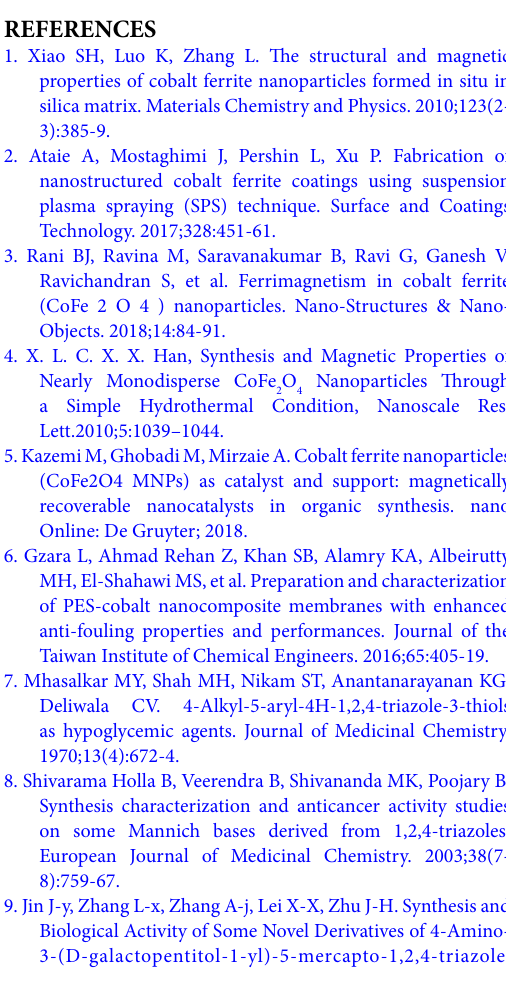
No. of Fig. 11. Reusability studies of CoFe2O4@SiO2 for the synthesis of 5-(4-Chlorophenyl-1,2,4-triazolidine-3-thione (2a) Figure 11: Reusability studies of CoFe 2 O 4 @SiO 2 for the synthesis of 5-(4Chlorophenyl-1,2,4- triazolidine-3-thione (2a) CONFLICTS OF INTEREST There are no conflicts to